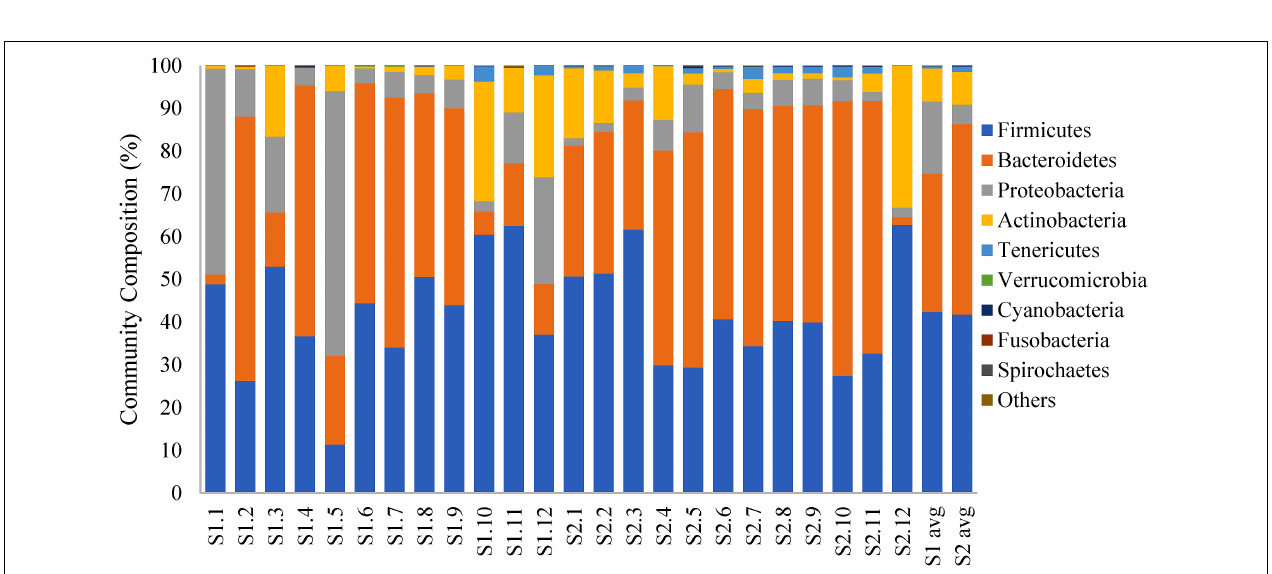
FIGURE 2 | 100% stacked bar plot showing relative abundance (%) of bacterial phyla in fecal samples collected from veal calves soon after they were brought onto the farms (Sampling 1/S1, n = 12) and fecal samples from the same cohort of calves at slaughter-age (Sampling 2/S2, n = 12). The last two columns are the average community composition for samples from the two stages of veal